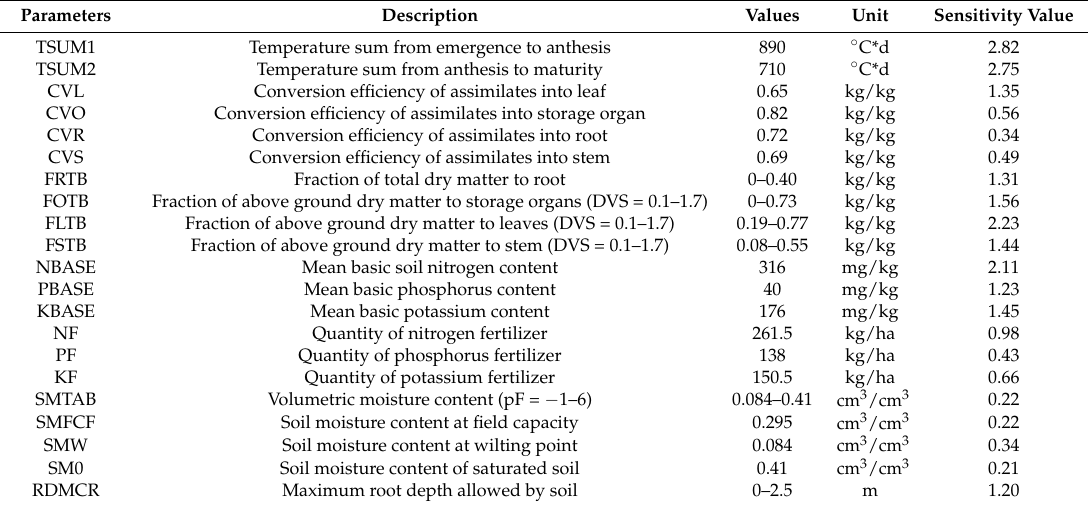
Table 3. Crop and soil parameter calibration results of the WOFOST